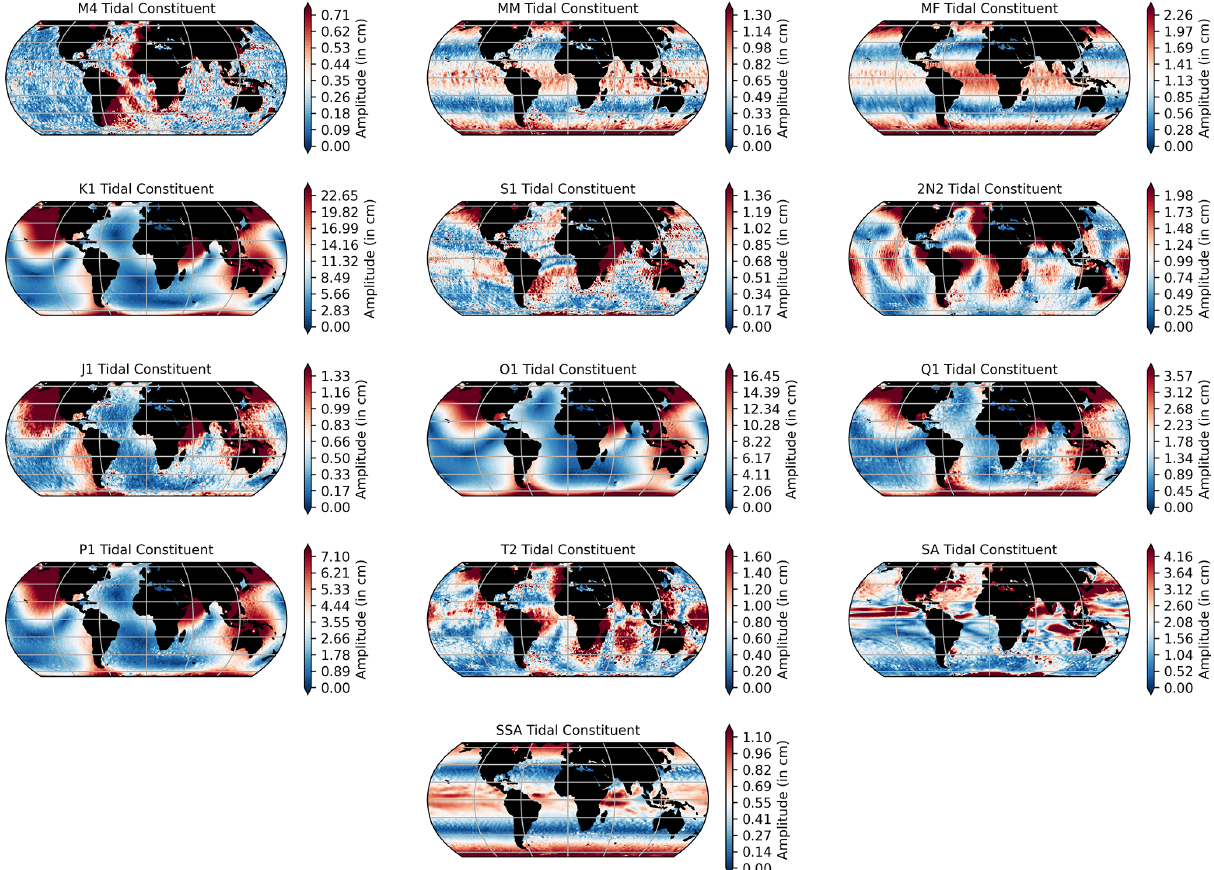
Figure A1. The amplitude of the remaining ocean tide constituents provided by EOT20.